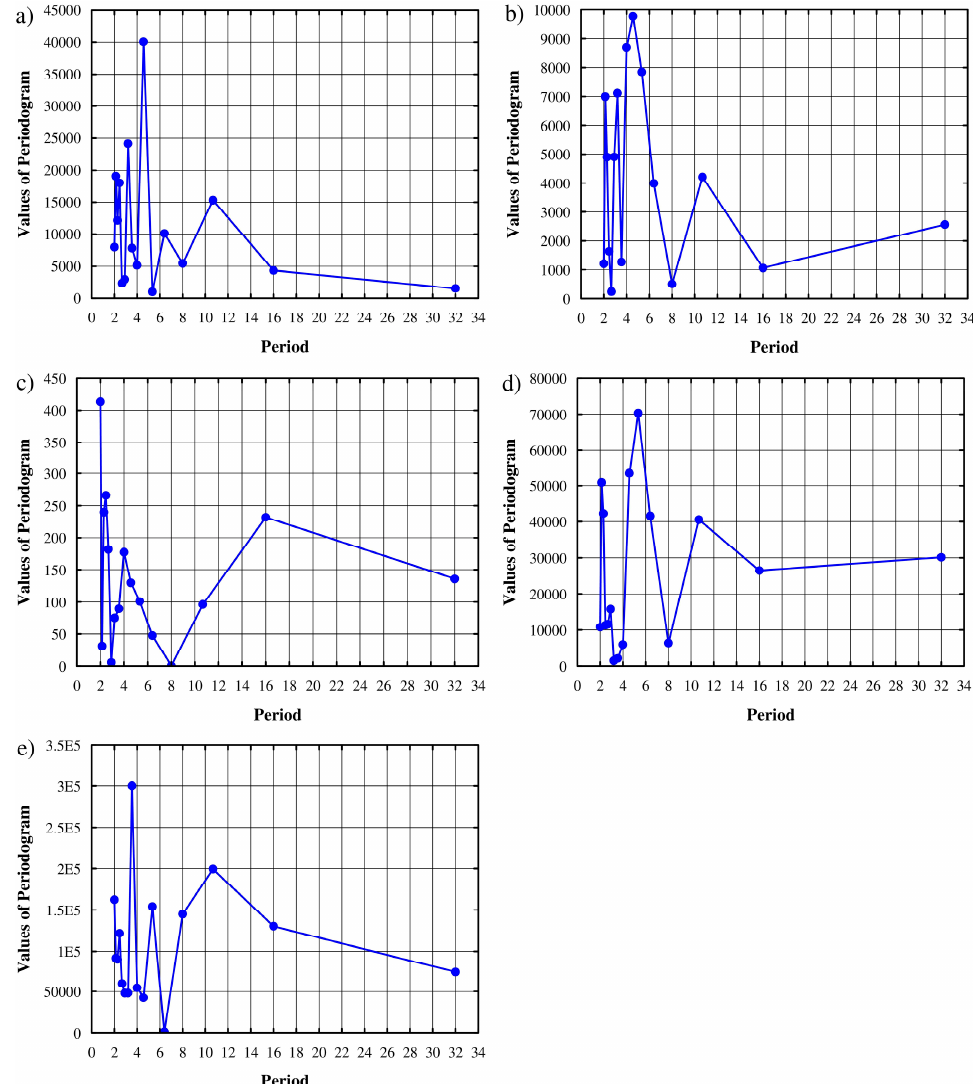
Figure 7. Periodograms of Q max for: ( a ) the Dunajec; ( b ) the Kamienica Nawojowska; ( c ) the Rudawa; ( d ) the Wis ł ok; ( e ) the San.